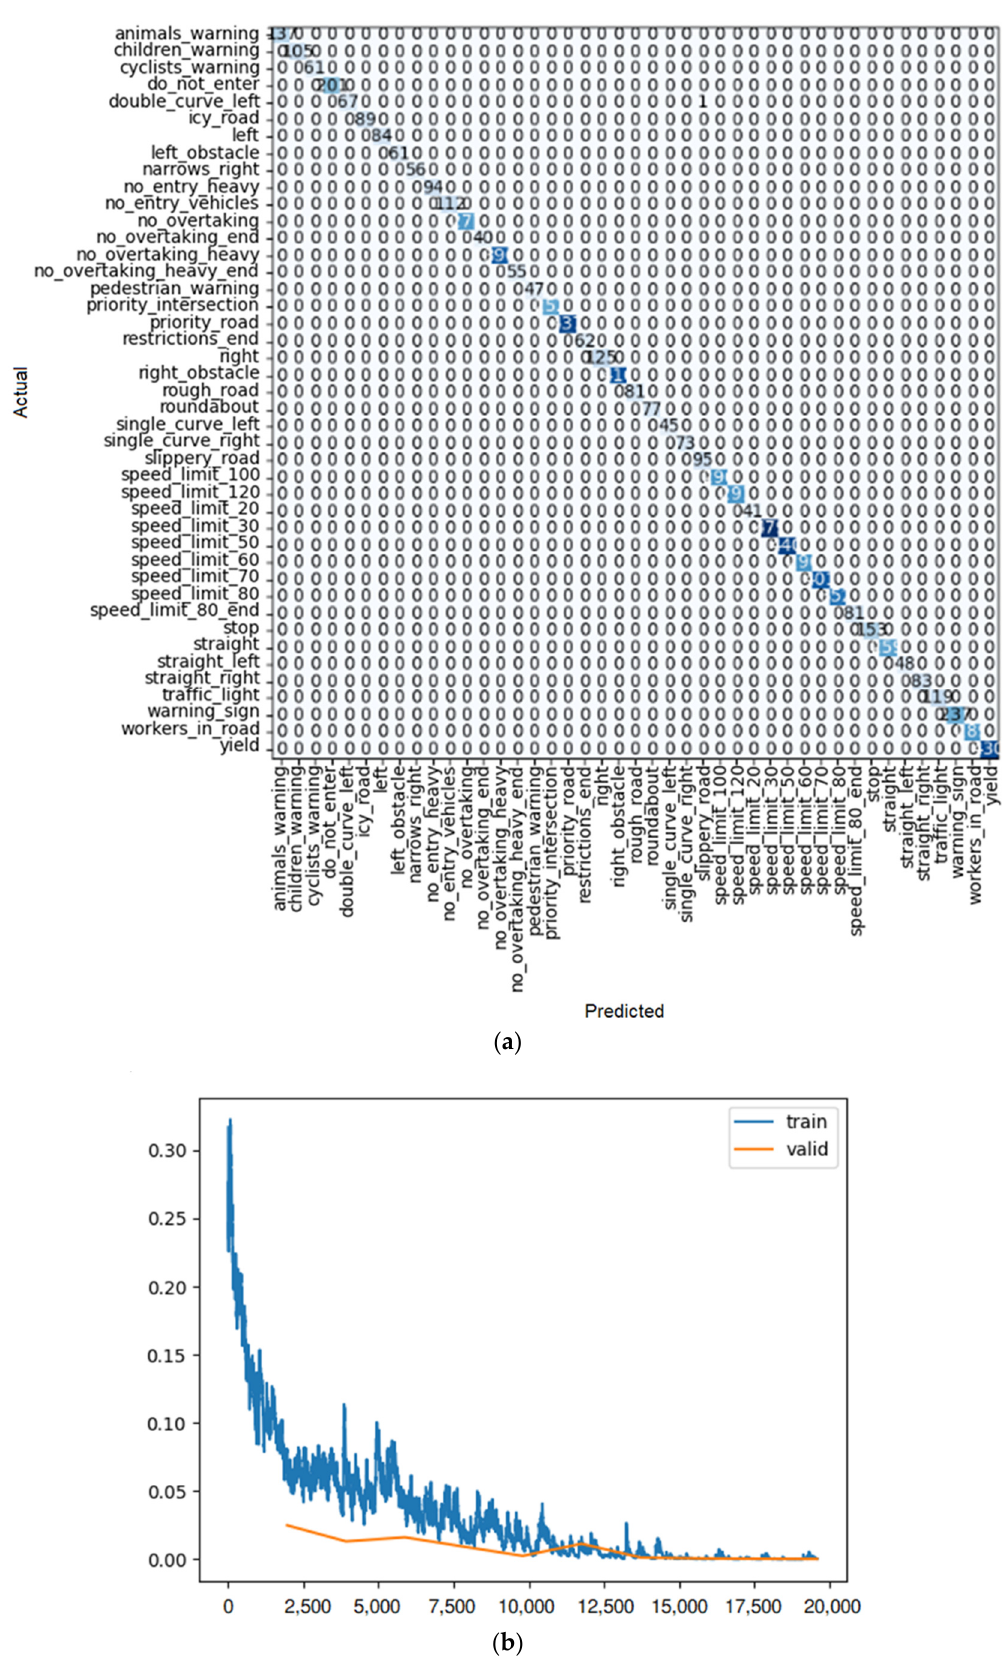
Figure 19. ( a ) Confusion matrix and ( b ) loss rate during training with DenseNet 121.